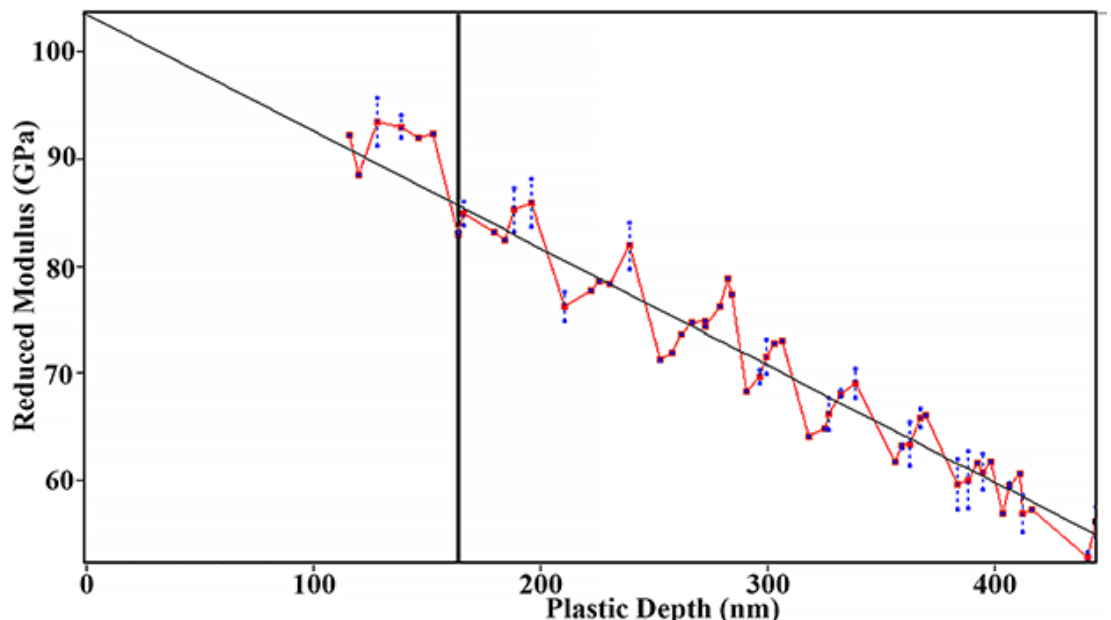
Figure 6. Reduced Young’s modulus of amorphous FeMnNiAlC 10 thin film.